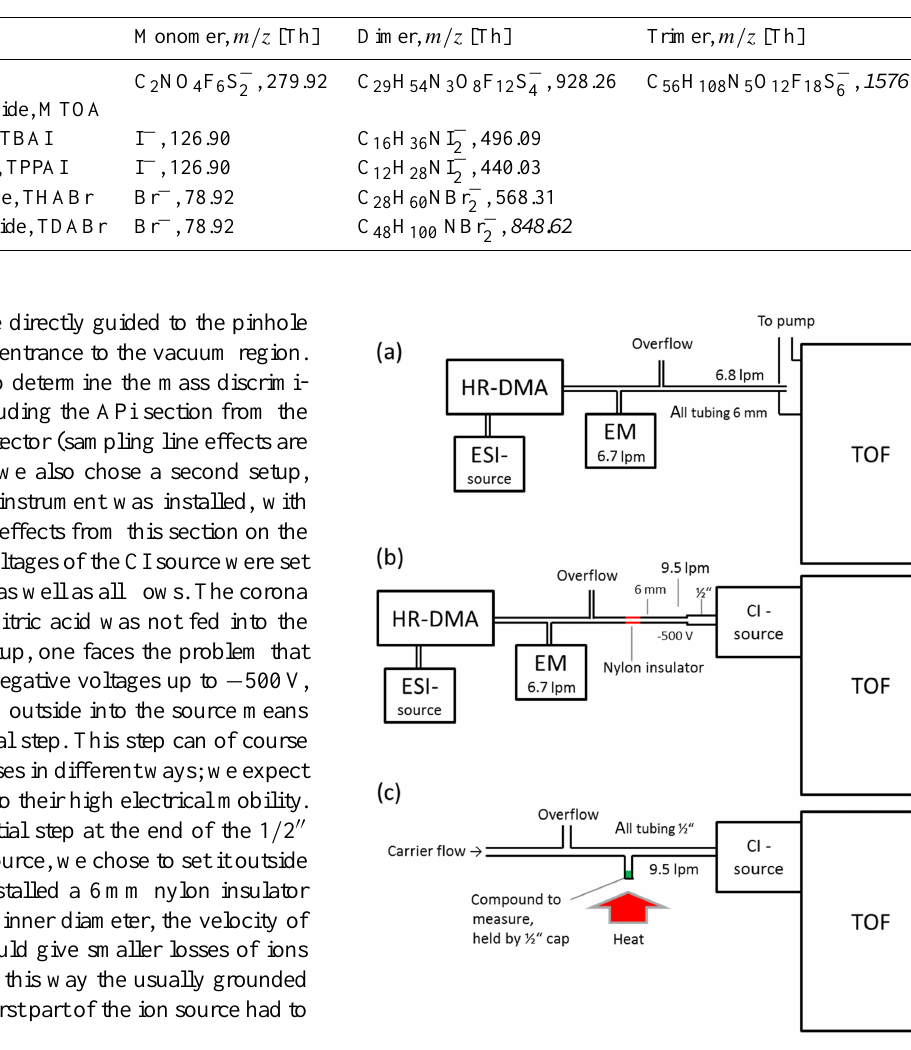
Table 1. Compounds used for HR-DMA method with according monomer, dimer, and trimer. Trimers were not always quantifiable as the HR-DMA also selected multiply charged higher clusters when adjusted for trimers (indicated by italics). This was also the case for the tetradodecylammonium bromide dimer.